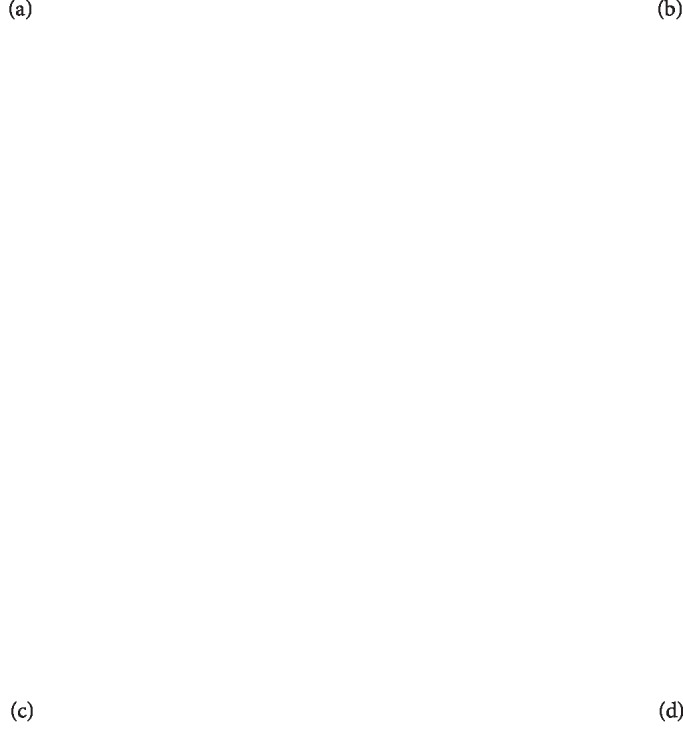
Effect of KXS on oxidative stress and neuroinflammation-induced apoptosis. KXS treatment relieved the accumulation of ROS in the rat hippocampus (a). Effect of KXS on representative proinflammatory factors TNF-α (b) and IL-1β (c). Downregulation of apoptosis-related proteins Bax and bcl-2 by KXS treatment in the rat hippocampus resulted in a decrease of cleaved-caspase-3. Values were mean ± SE (n = 6). The column diagrams marked by different letters were significant to each other at the 0.05 level according to Duncan's multiple range test.